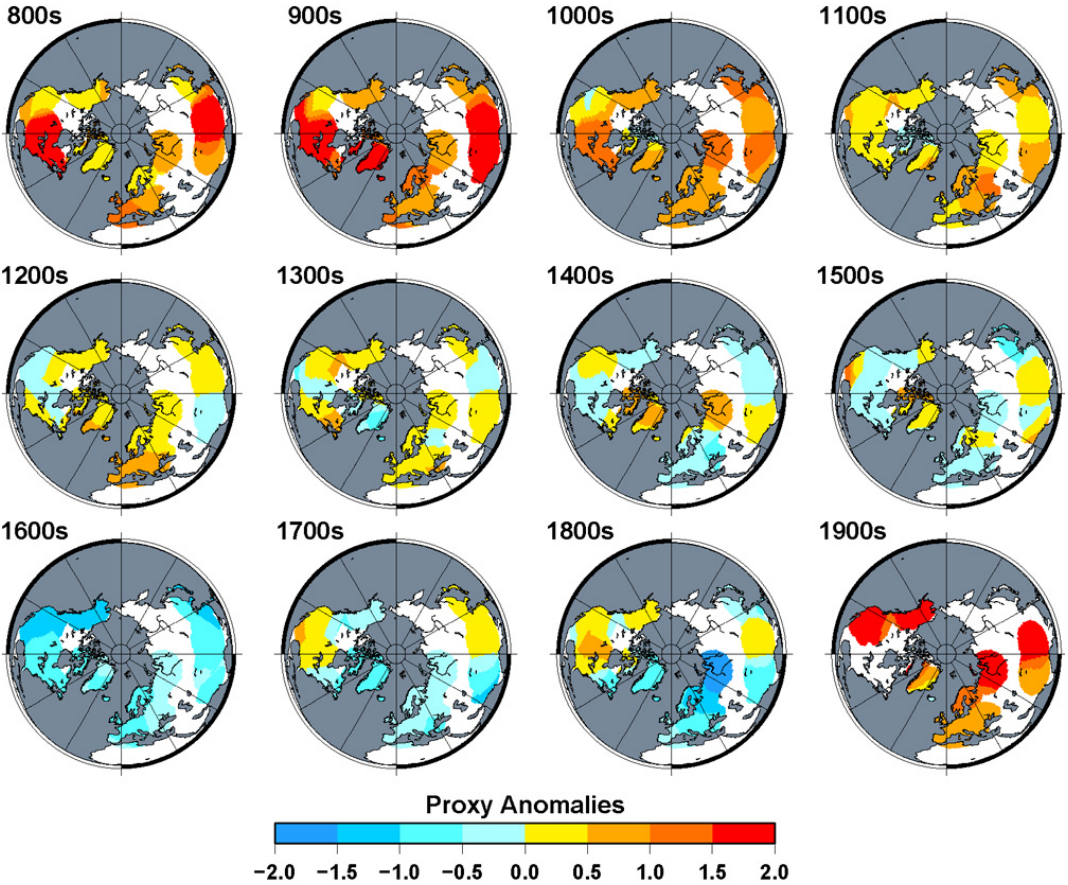
Fig. 3. Gridded, weighted, centennial proxy anomalies derived from the data shown in Fig. 1. Anomalies are shown relative to the 11th–19th century reference period. The colour scale is truncated at − 2 and